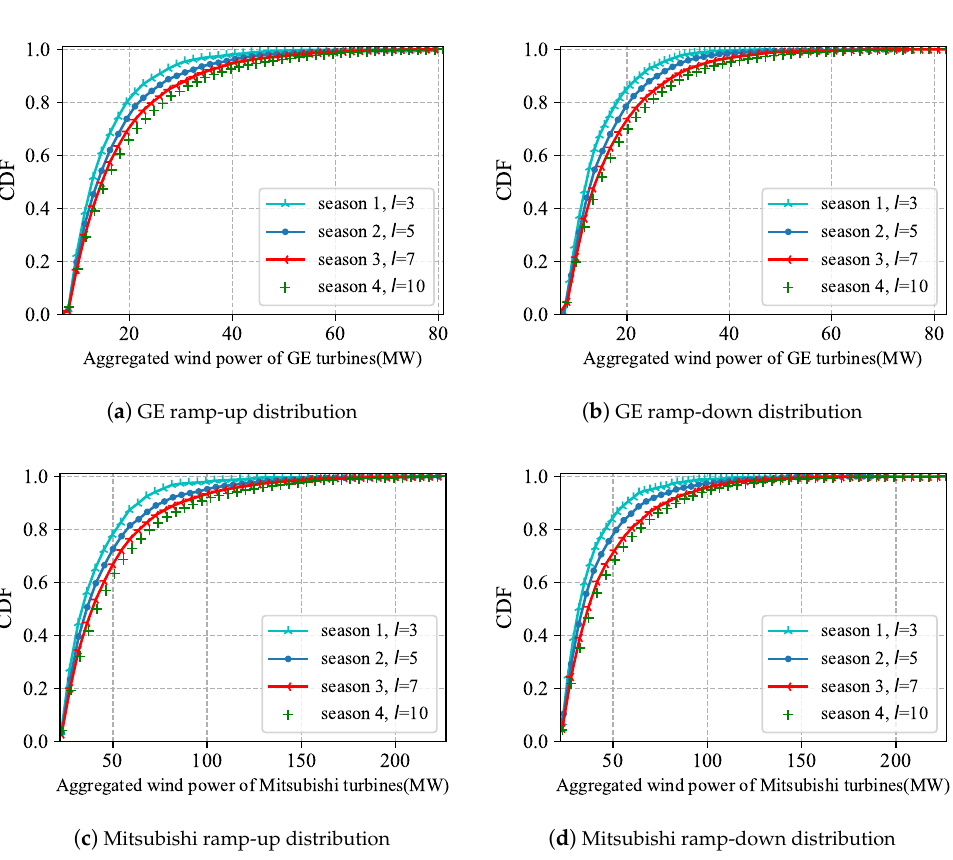
Figure 4. Empirical ramp distributions of GE and Mitsubishi turbines in different time windows l and different time periods, which follow the generalized Pareto